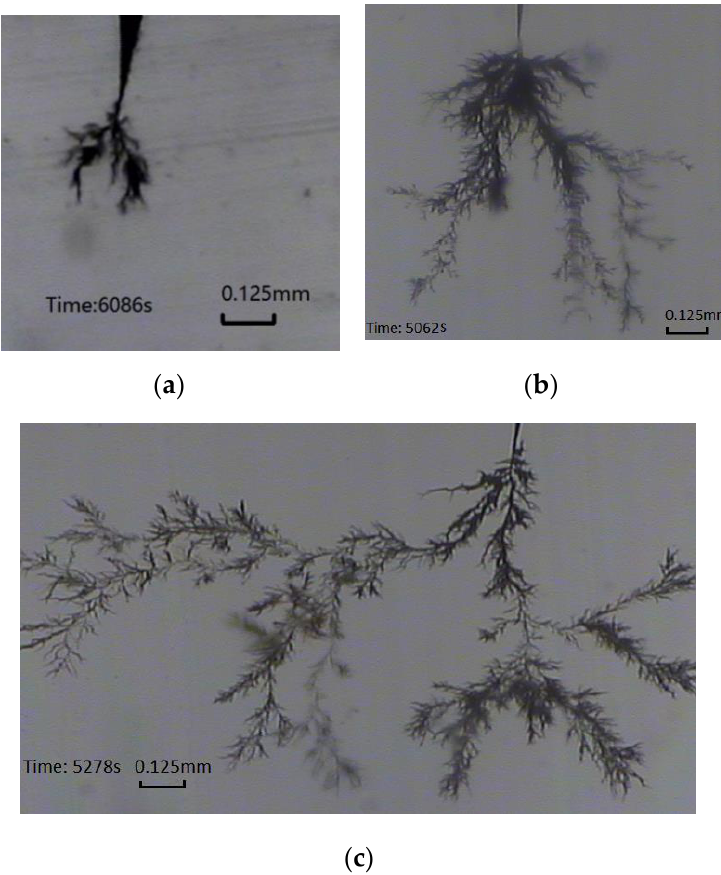
Figure 7. Electrical-tree growth of XLPE EMJ in ( a ) cable body, ( b ) recovery insulation, and ( c ) interface region.